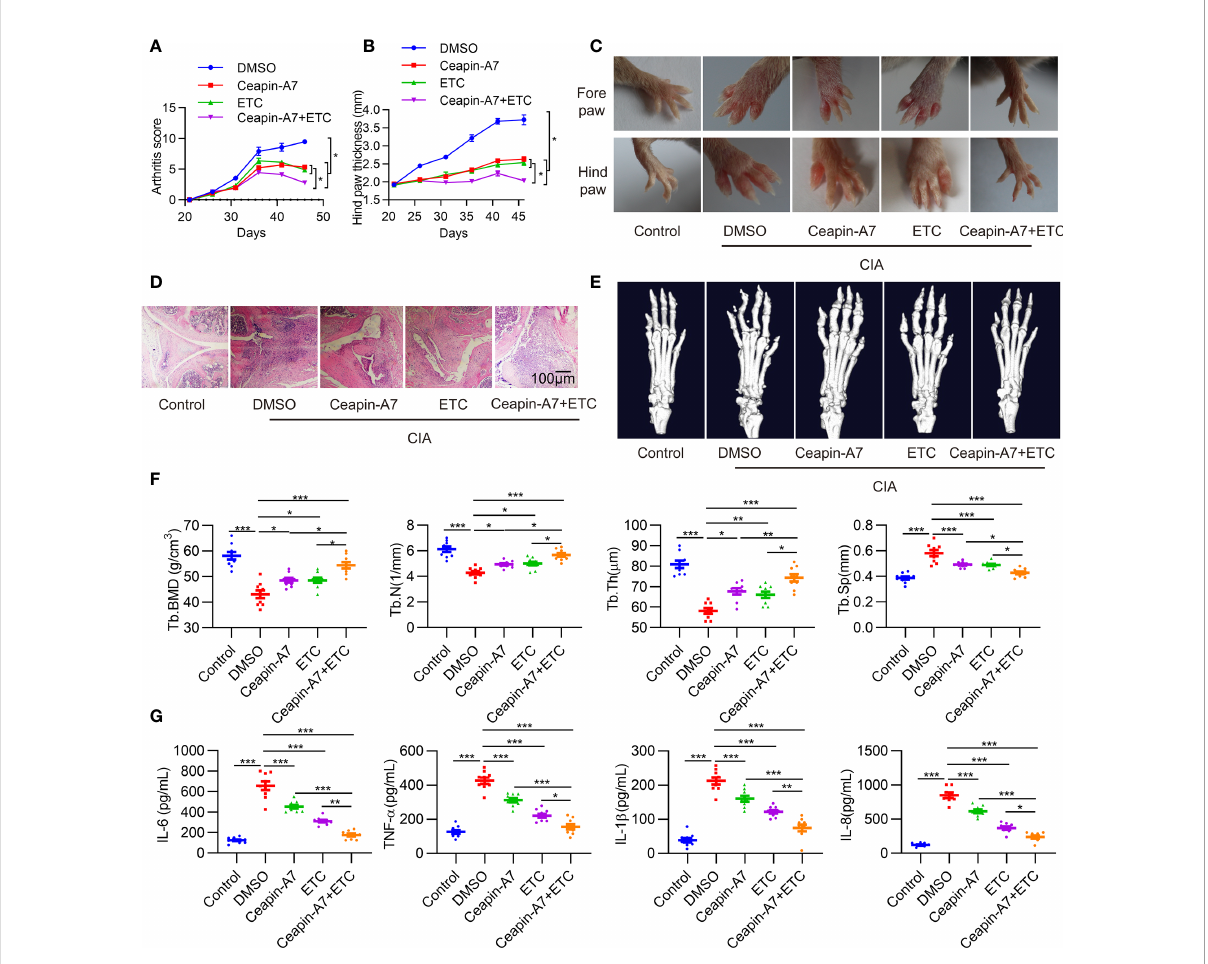
FIGURE 4 Ceapin-A7 delays CIA development. (A, B) , Arthritis score and hind paw thickness of CIA from day 22 to day 45 in indicated groups of CIA mice. (C) , Representative photographs of the fore and hind paws of CIA and control mice on day 45. (D) , Representative H&E staining of knee joints from CIA mice and the control mice. (E) , Micro-CT representative images of hind paws. (F) , Quantitative analysis from micro-CT evaluation. (G) , Mice serum levels of IL-6, IL-8, TNF- a , and IL-1 b were measured by ELISA. Data were expressed as mean ± SD ( n = 9 in per group), n represent biologically independent mice (A, B, F, G) . The data were analyzed using two-way ANOVA analysis. * P <0.05, ** P <0.01, *** P <0.001. Tb.Th: trabecular thickness; Tb.BMD: trabecular bone mineral density, Tb.N: trabecular number; Tb.Sp: trabecular separation, ETC: